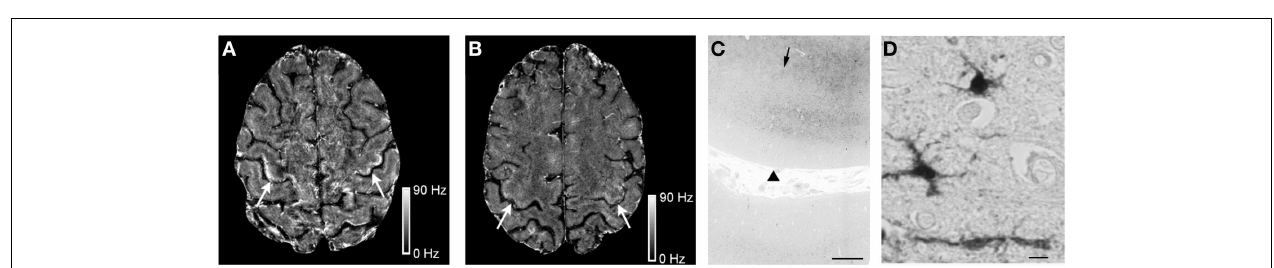
Pearl’s staining (arrowheads indicate the pial surface while arrows indicate the gray–white junction). (C) At higher magnification, Pearl’s staining detects Fe in cells with irregular processes suggestive of microglia in the ALS motor cortex. (D) Scale bars: C, 1mm; D, 10 µ M. Reproduced with permission and minor modification from Kwan et al.